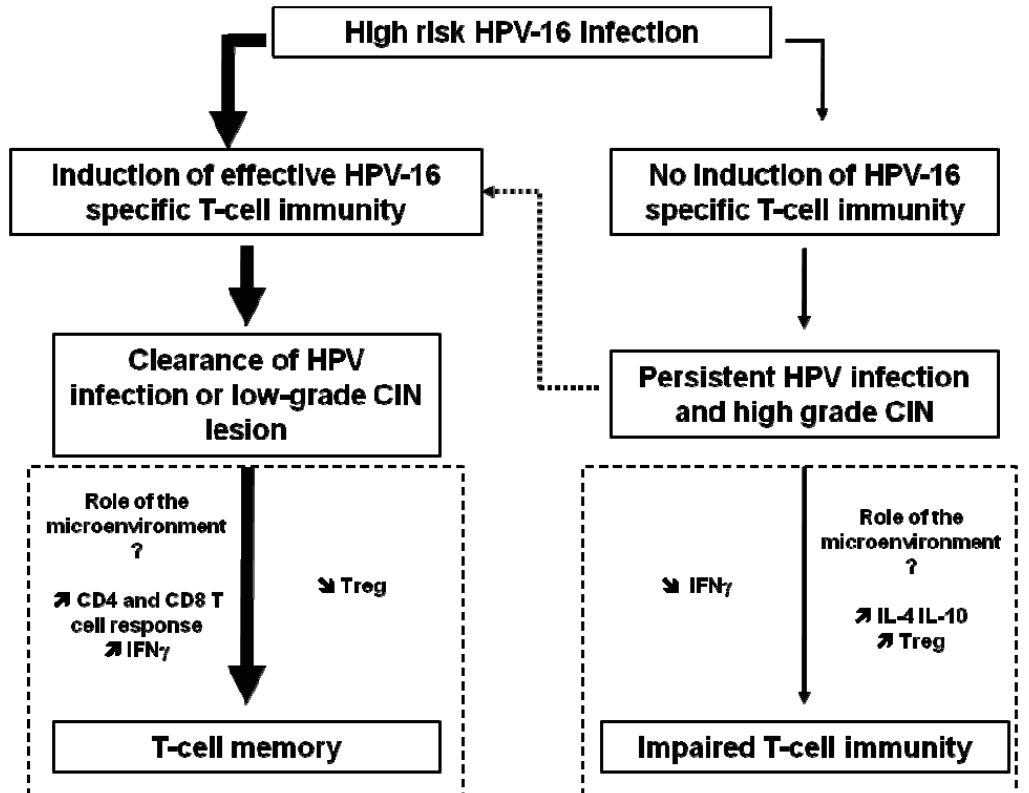
Figure 1. Proposed model for the association between HPV-16-specific T-cell immunity and the development of disease (adapted from [26]). Thick arrows represent the fate of the majority of HPV-16-infected individuals, in contrast to thin arrows that represent the fate of the minority of HPV-16-infected individuals. Dotted arrow indicates that some cases of spontaneous regression can occur, probably by the induction of T-cells and/or cells from the microenvironment, which leads to the destruction of infected tissues or tumor mass. Dashed box represents the immunological mechanism that is likely